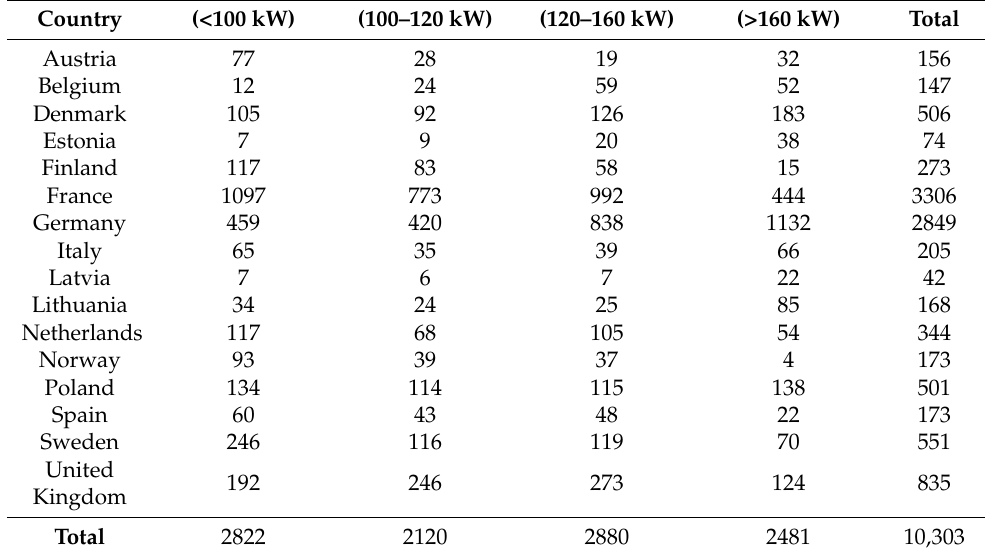
Table 3. Dataset size grouped by country and power